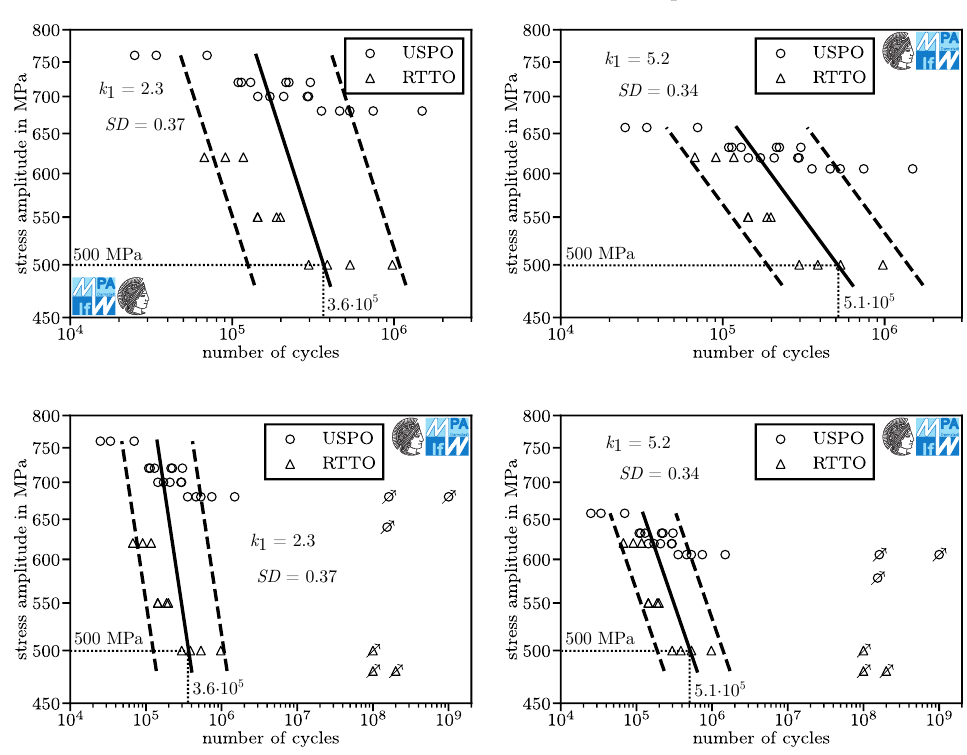
Figure 12. Fatigue behavior of 50CrMo4 in laboratory air; 1096 MPa ultimate tensile strength; K t = 1.2; run-outs are marked with an arrow; left side: before correction; right side: after correction; top: only HCF region; bottom: including VHCF